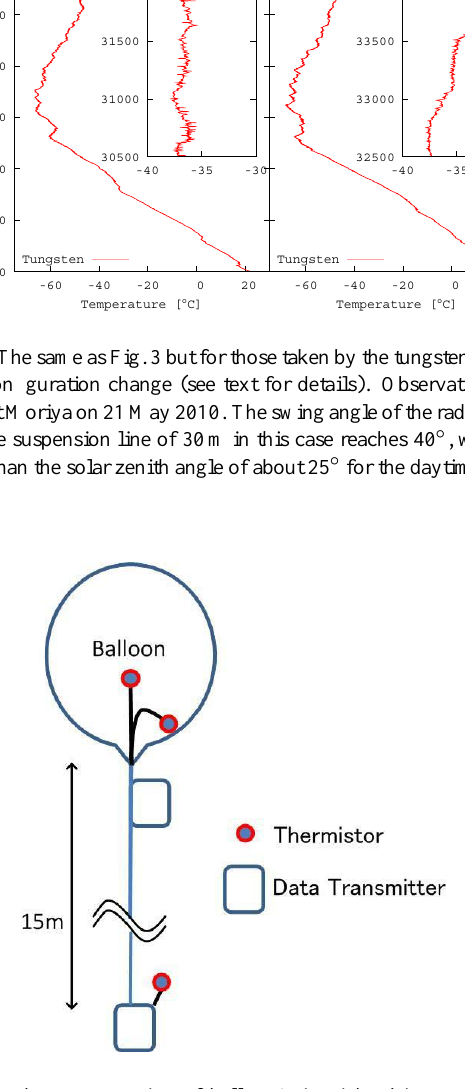
Fig. 9. The configuration of balloon’s in-flight skin temperature observation. Three independent thermistors are installed to measure the temperatures both the inside and the outside (15m below) the balloon in addition to the skin. The data of two thermistors in the balloon have been taken out to the outside through the